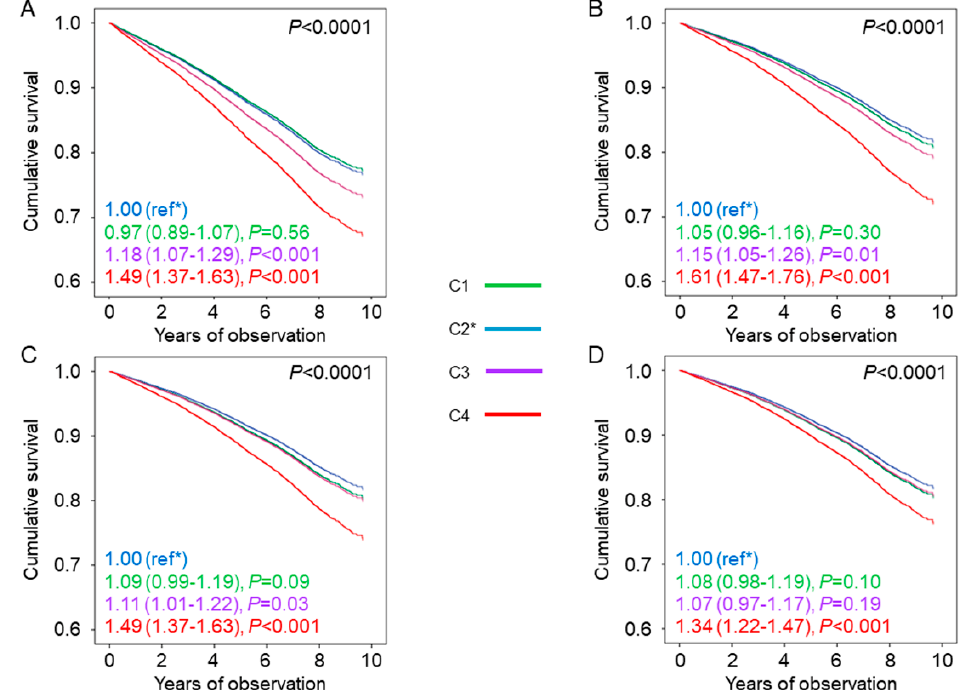
Figure 1. Mortality risk by HbA 1c categories. Cox proportional hazards regression according to HbA 1c categories, unadjusted ( A ) and adjusted for age and gender ( B ), plus cardiovascular disease (CVD) risk factors ( C ), plus complications / comorbidities ( D ). HRs (95% CI) for mortality are shown for each HbA 1c category. HbA 1c = haemoglobin A 1c ; HR = hazard ratio; CI = confidence interval; C1 = HbA 1c < 6.5%; C2 = HbA 1c 6.5%–7.49%; C3 = HbA 1c 7.5%–8.49%; C4 = HbA 1c ≥ 8.5%; ref*, the asterisk indicates the reference category. Table 1. Baseline clinical features of study participants by HbA 1c categories.